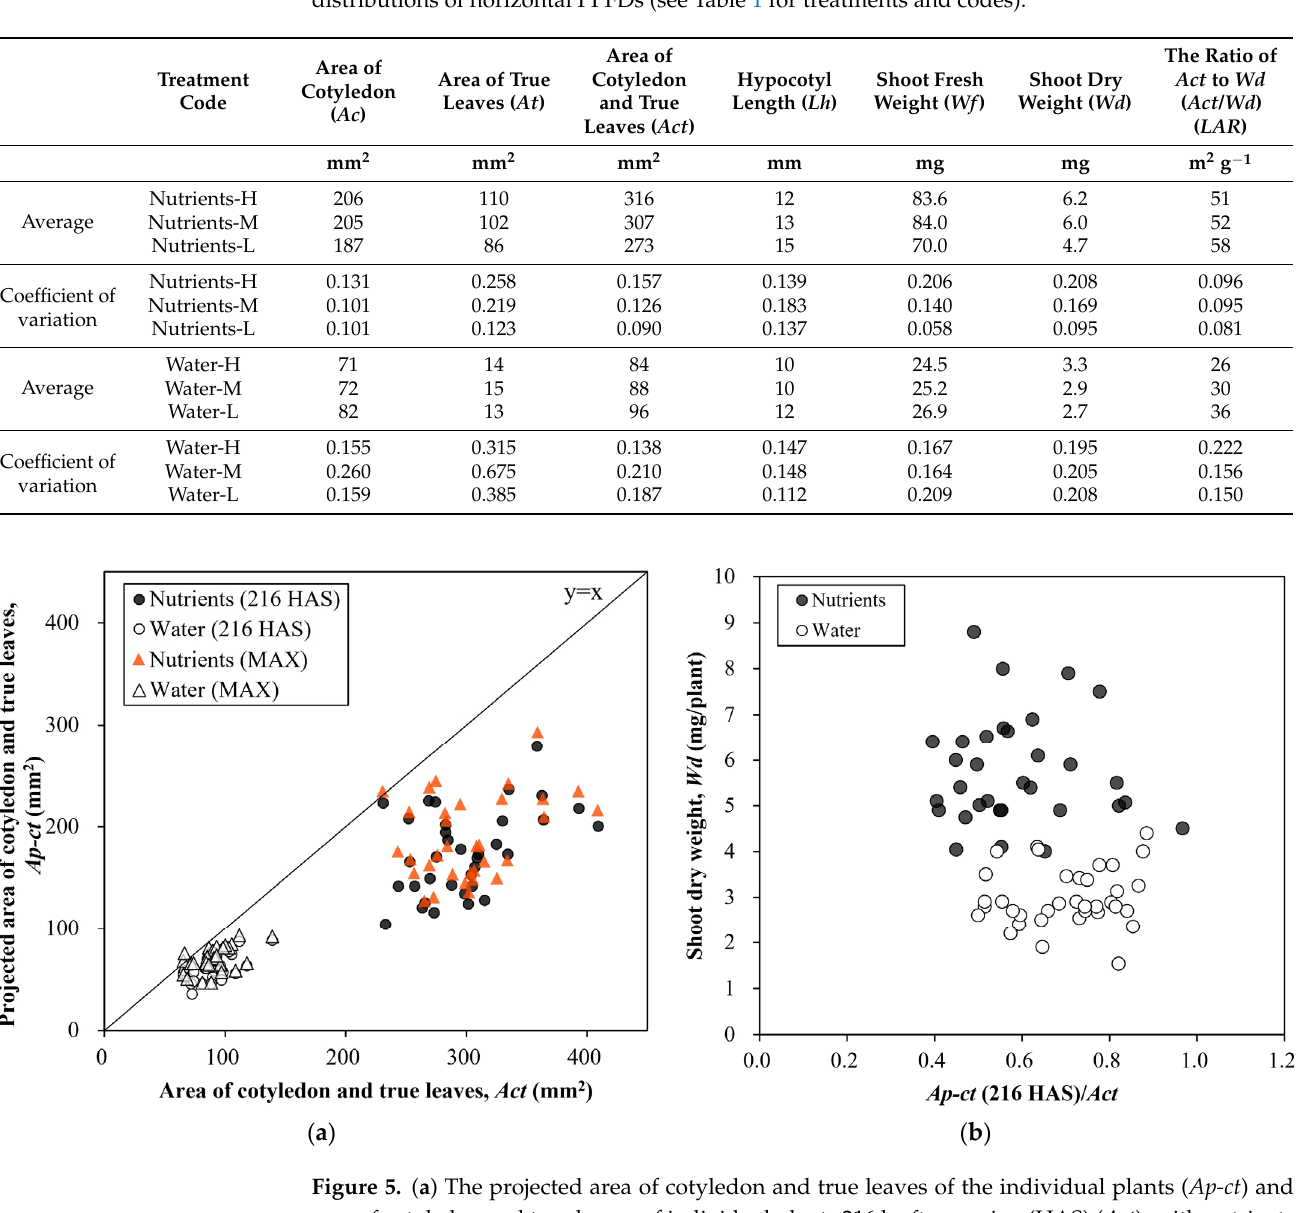
Table 4. Average and coefficient of variation of areas of the cotyledon ( Ac ), true leaves ( At ), and the sum of individual Ac and At ( Act ), hypocotyl length ( Lh ), shoot (cotyledon, true leaves, hypocotyl, and petiole) fresh weight ( Wf ), shoot dry weight ( Wd ), and the ratio of Act to Wd ( LAR ) of individual seedlings measured respectively 216 h after sowing (HAS) with nutrients and water, each with distributions of horizontal PPFDs (see Table 1 for treatments and codes).